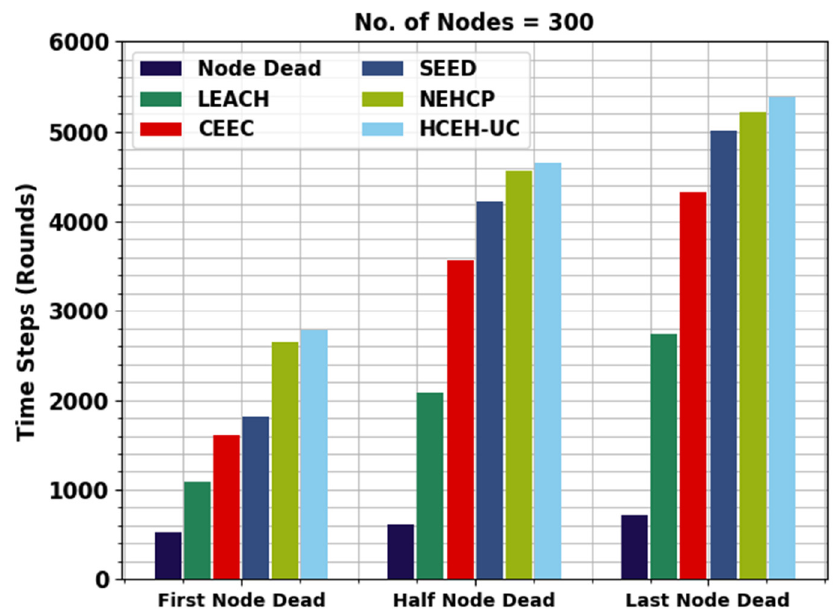
Figure 4. Lifetime analysis of WMAO-EAR approach under NC of 300.